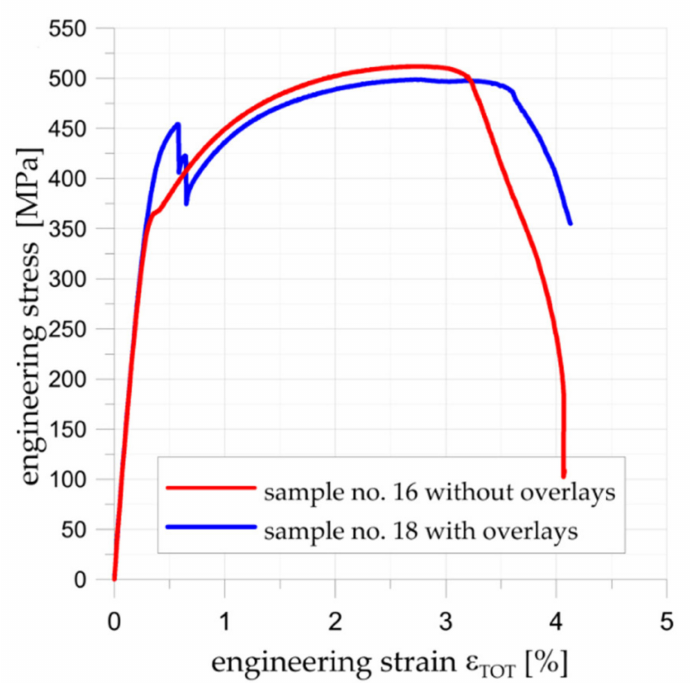
Figure 19. Comparison of tensile curves for samples without (no. 16) and with composite overlays (no. 18).